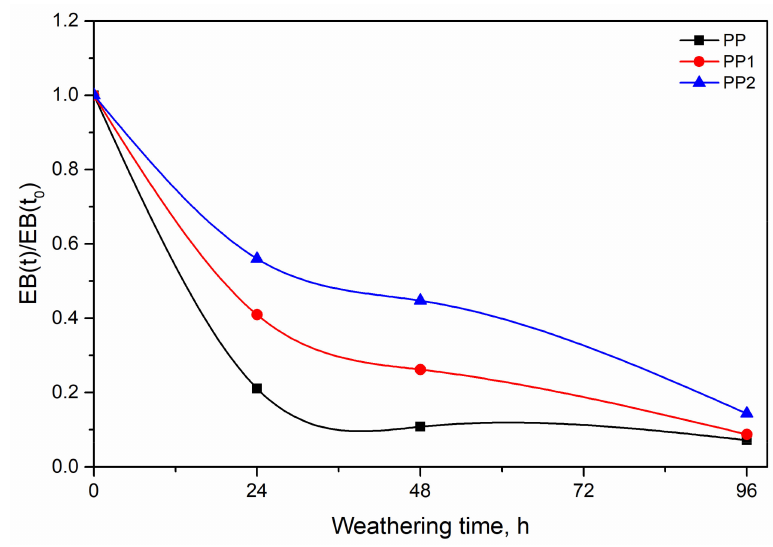
Figure 10. Relative elongation at break as a function of weathering time.